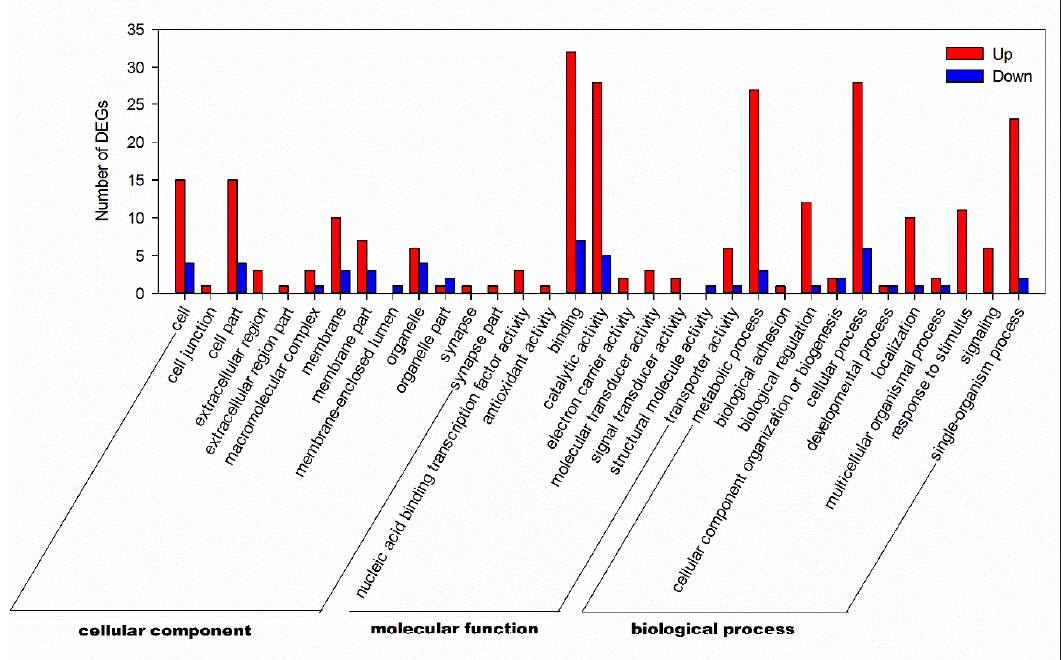
Figure 2. Distribution of up- and down-regulated DEGs among the Gene Ontology (GO) terms in the biological process, cellular component, and molecular function categories.